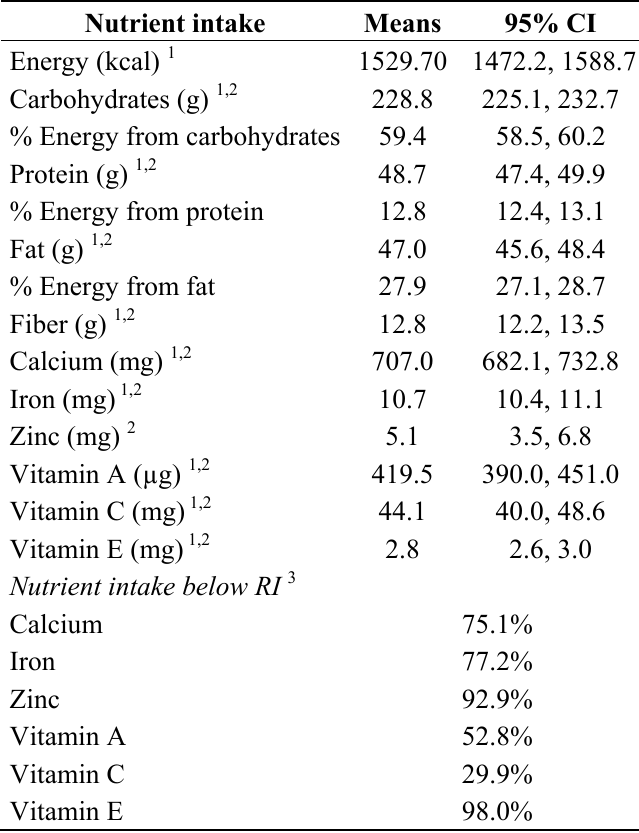
Table 3. Energy, macronutrients and zinc, iron, vitamins A and C intake of the children that participated in the study ( n =